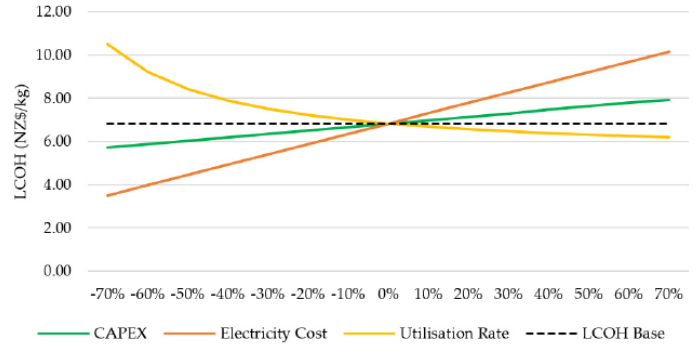
Figure 5. Hydrogen cost sensitivity graph.